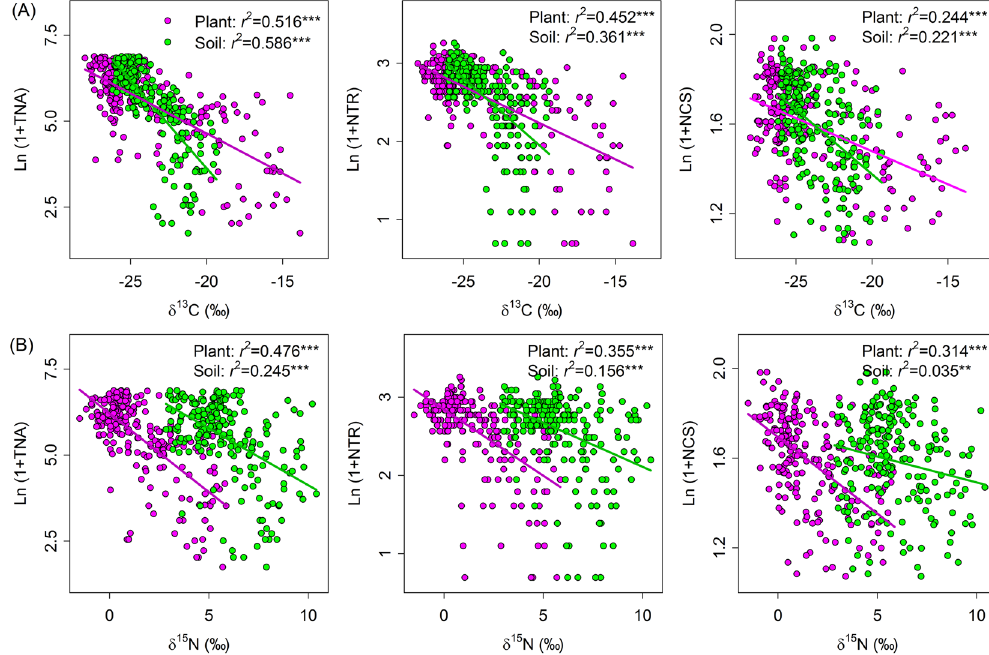
Figure 3. Relationships between nematode community variables and ( A ) δ 13 C isotopic values and ( B ) δ 15 N isotopic values of plants (pink symbols) and soils (green symbols) at the regional scale in the Mongolian grassland. Abbreviations are explained in Table 1. Regression analysis is indicated by r 2 and significance level ( ** P < 0.01; *** P <